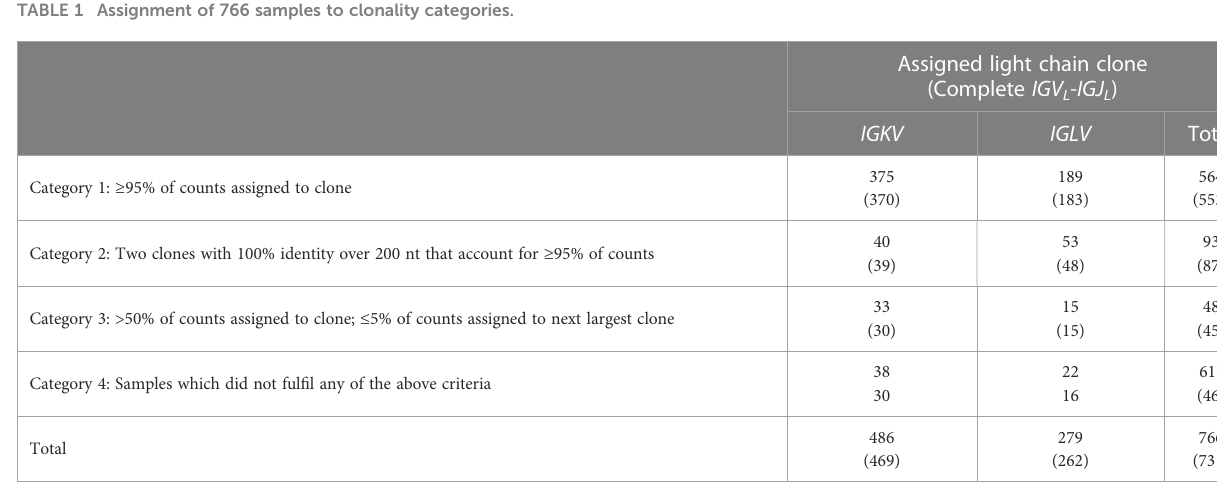
TABLE 1 Assignment of 766 samples to clonality categories.